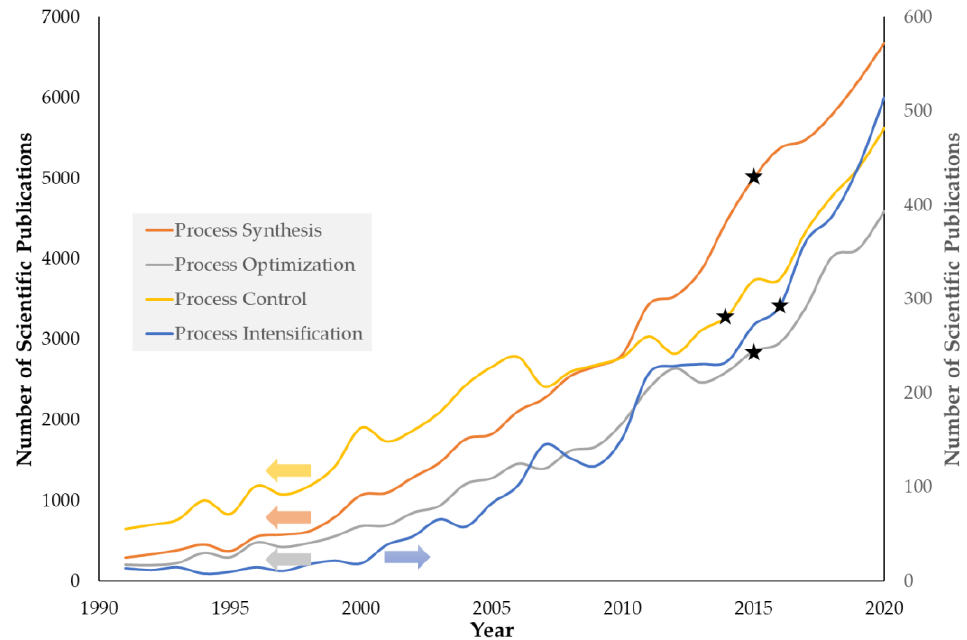
Figure 1. Scientific publications between 2020 and 1991. Source: SCOPUS© .